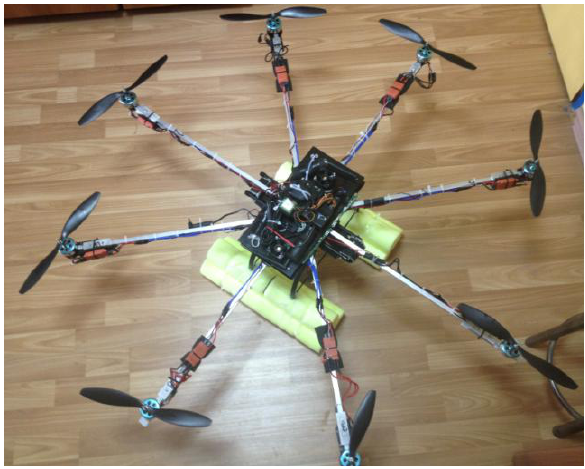
Figure 1. The designed low cost light UAV